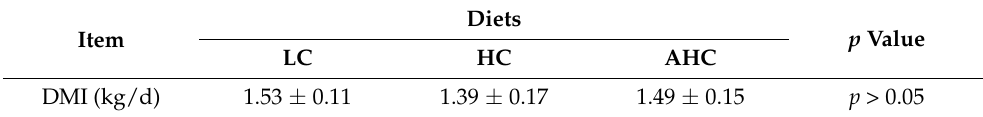
Table 2. Supplemental disodium fumarate effects in dry matter intake of Hu sheep.